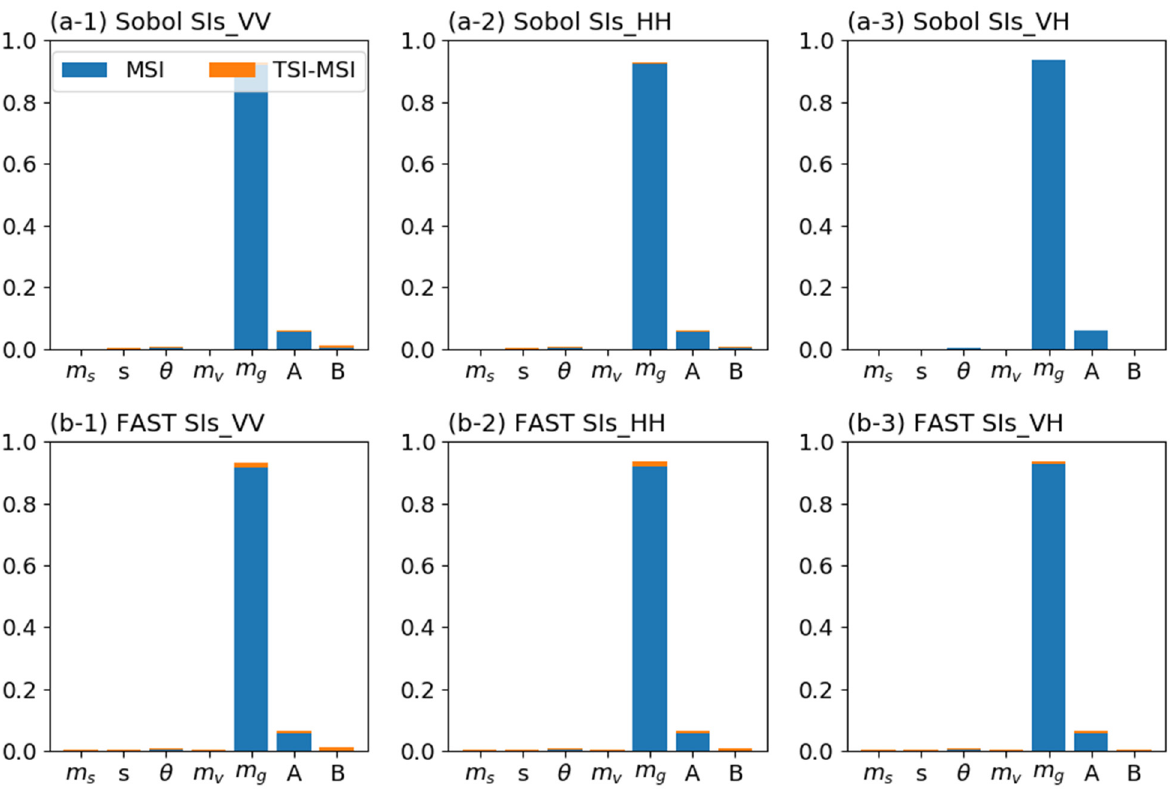
Figure 4. Parameter SIs from the two quantitative methods (Sobol’ and FAST) under the Park vegetation description scheme. MSI and TSI-MSI in Sobol’ and FAST methods represent the first-order effect (main sensitivity index, MSI) and the difference between total effect (total sensitivity index, TSI) and MSI.